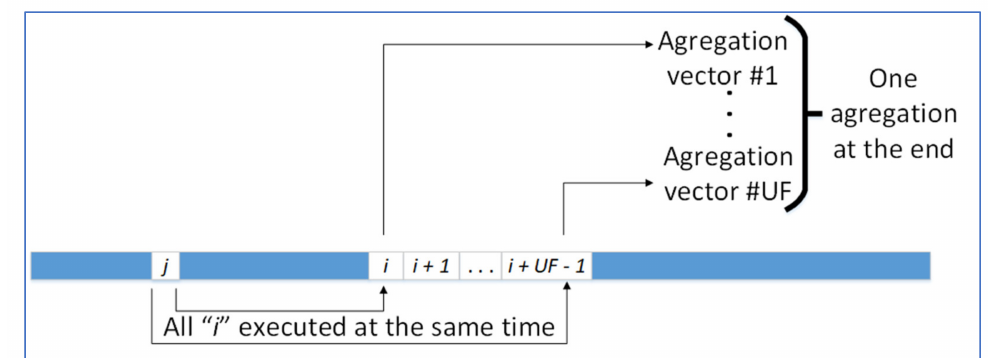
Figure 10. Schema of how the aggregation works with different unroll factors (UF). Here, j is a test particle, i another particle. Each time, UF operations are executed in